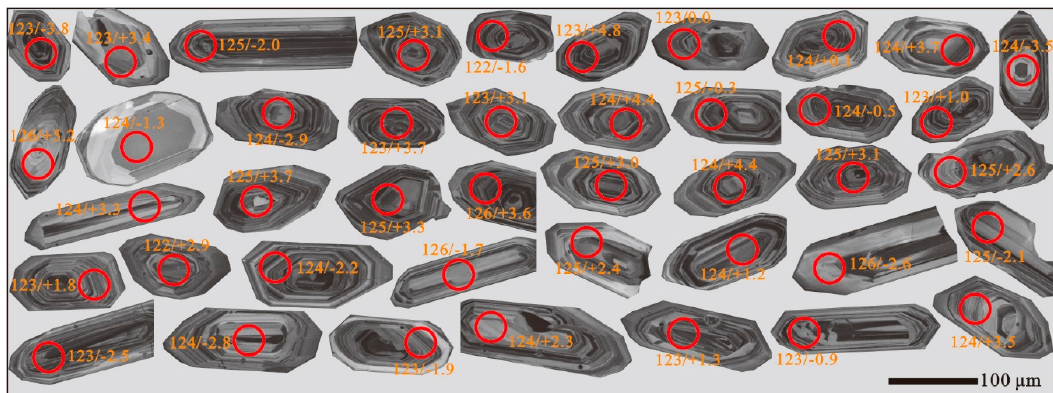
Figure 3. Cathodoluminescence images of representative zircons for in situ analyses of U ‐ Pb and Hf isotopes. Numbers next to analysis spots (red circles) are U ‐ Pb ages (Ma)/ ε Hf ( t ) values.